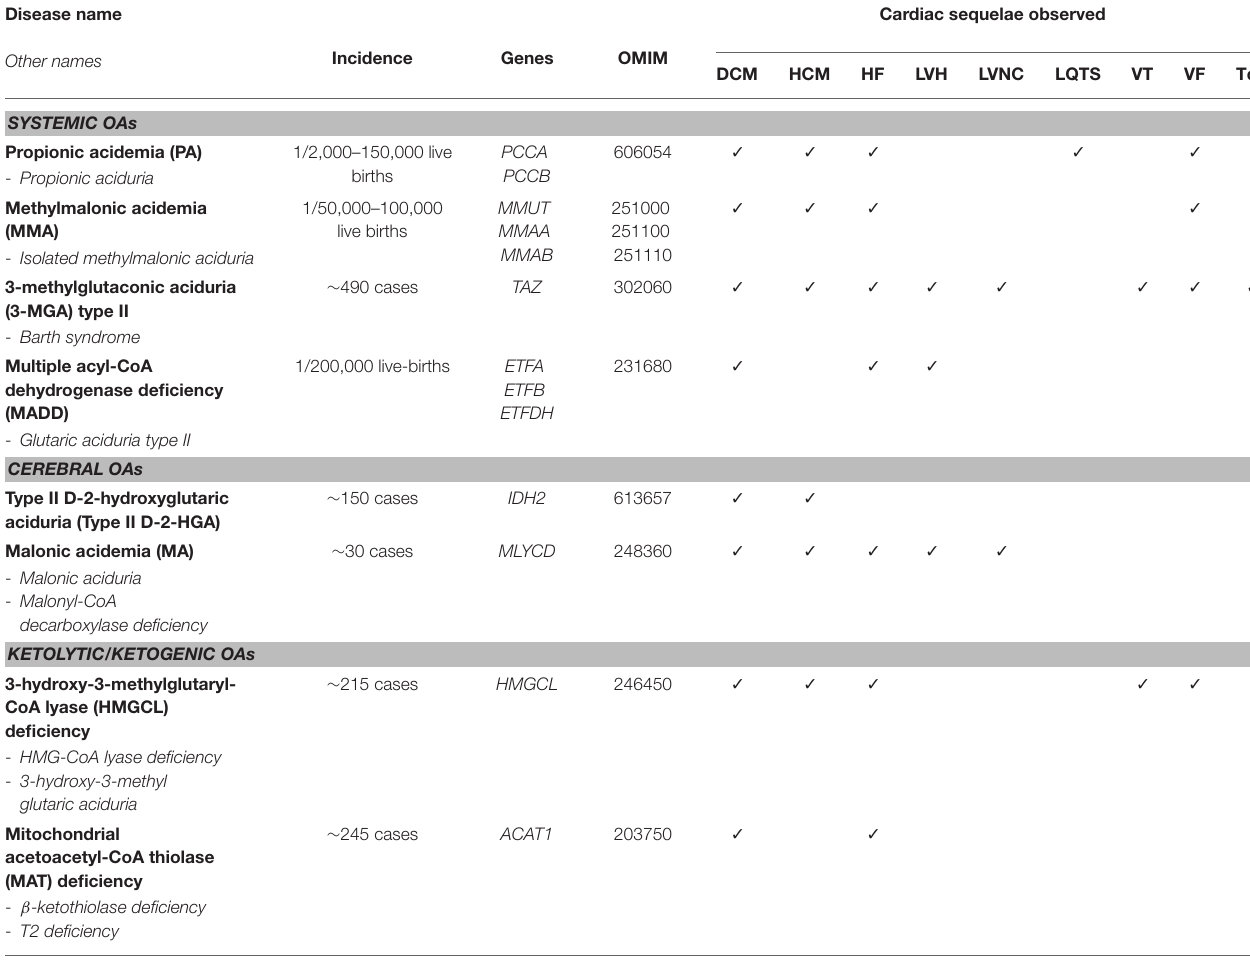
TABLE 1 | Reference table of the main OAs known to associate with cardiac dysfunction. Disease